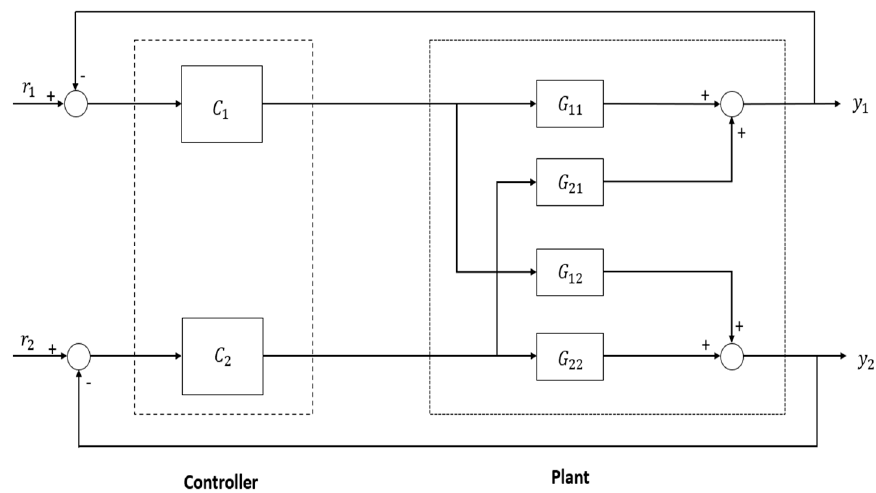
Figure 1. Diagram of cockpit flow and temperature control system.